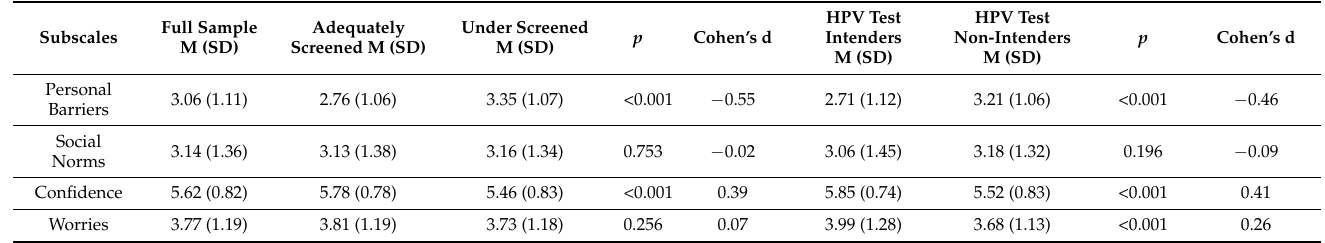
Table 4. Criterion validity analyses for the HPV Testing Attitudes and Beliefs